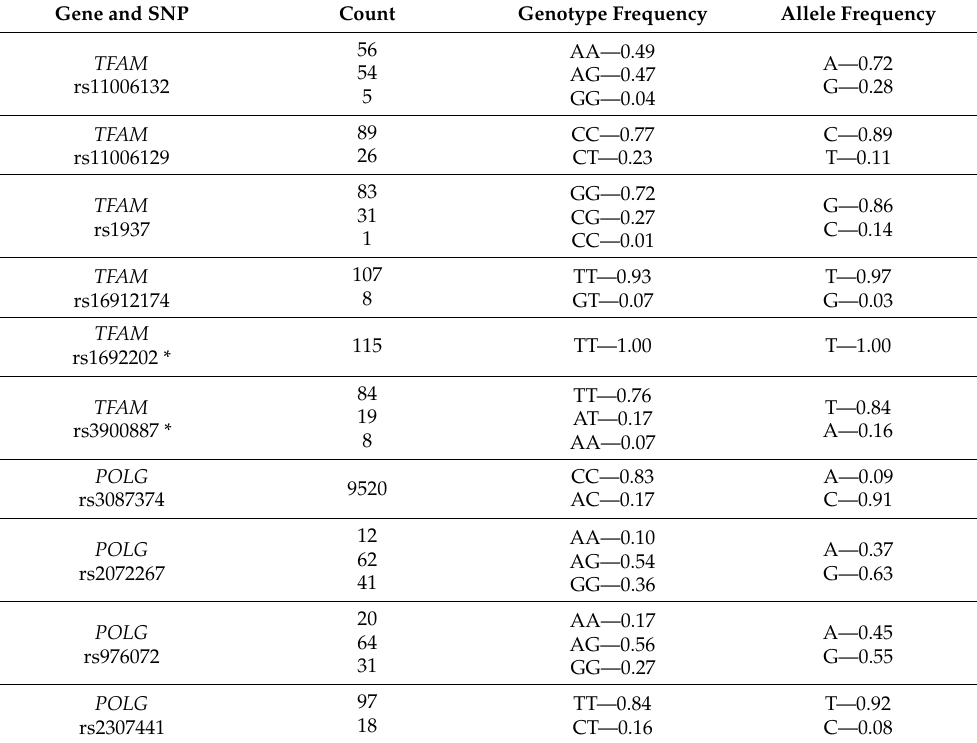
Table 3. The distribution of TFAM and POLG genotype and allele frequencies.